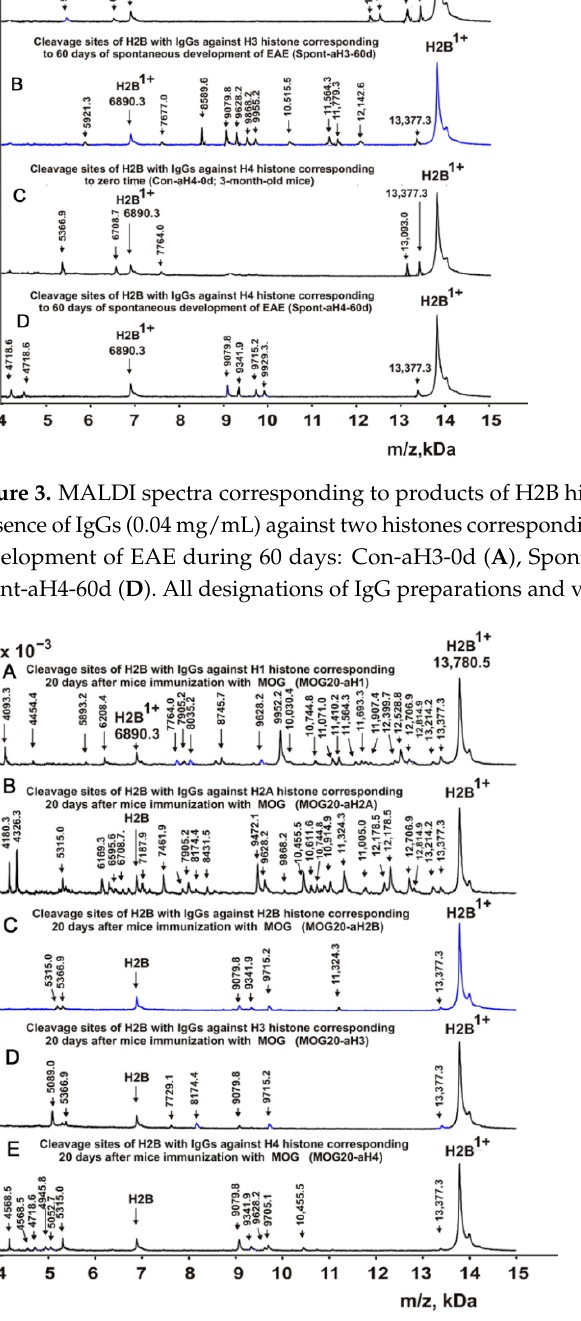
Figure 4. MALDI spectra of H2B (0.9 mg/mL) hydrolysis products with IgGs against the five histones corresponding to 20 days after mouse immunization with MOG: MOG20-aH1 ( A ), MOG20-aH2A ( B ), MOG20-aH2B ( C ), MOG20-aH3 ( D ), and MOG20-aH4 ( E ). All designations of IgG preparations and values of m / z are shown in the fi gure.